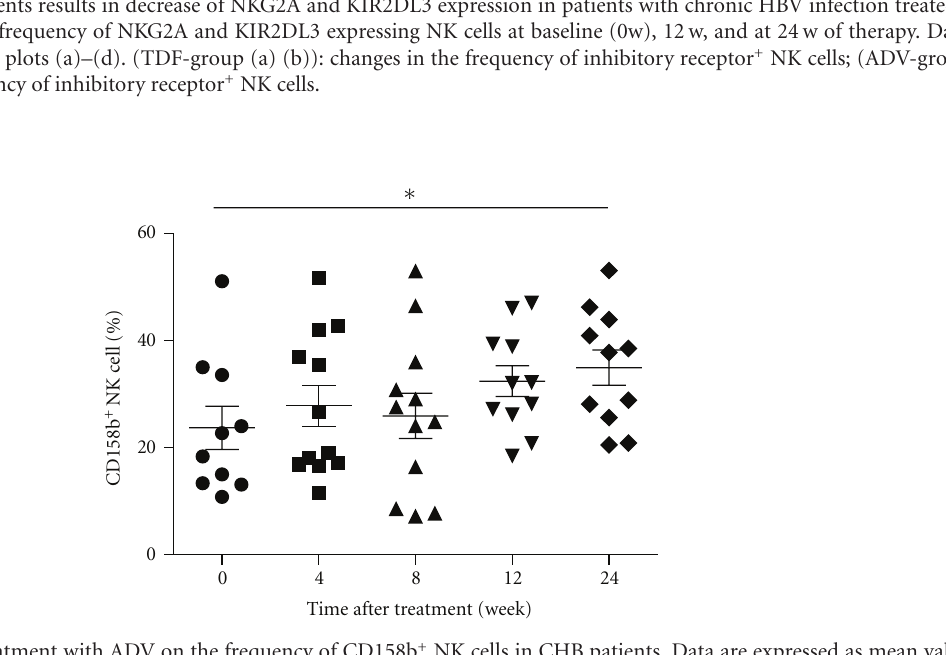
Figure 7: The e ff ect of treatment with ADV on the frequency of CD158b + NK cells in CHB patients. Data are expressed as mean values of individual patients at the indicated time points after